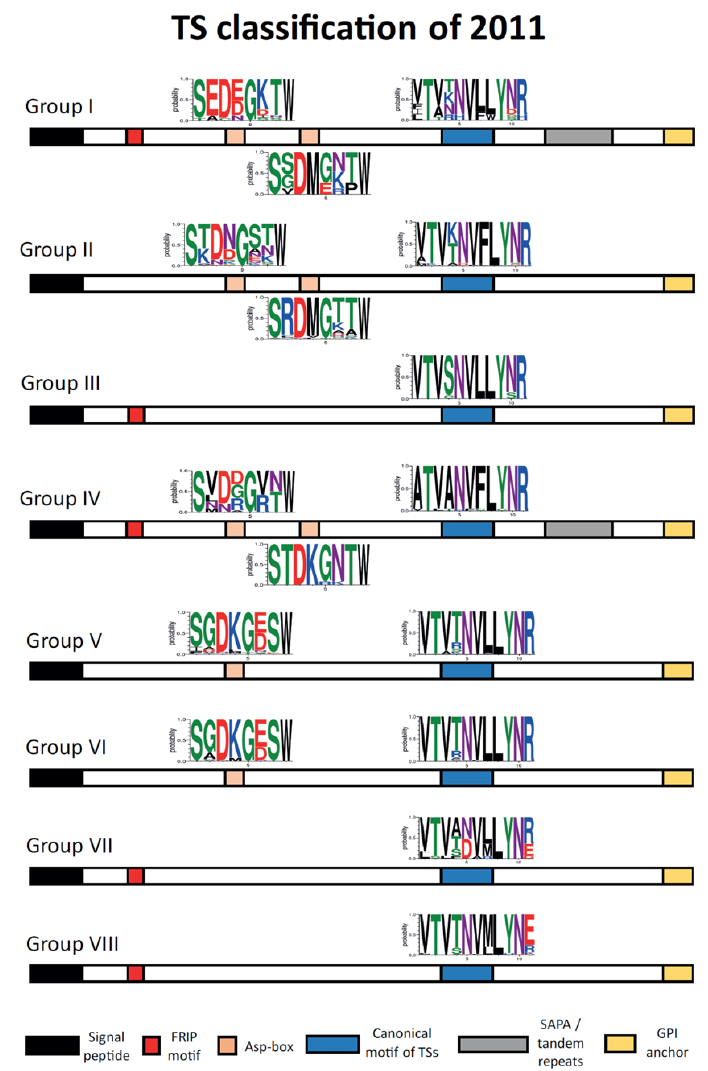
Figure 5. Classification of 2011 of TS members according to a sequence cluster analysis. Each group is defined by specific motifs. Logos of each Asp-box and canonical TS motifs are displayed. Adapted from Freitas, L. M. et al., 2011 [110].